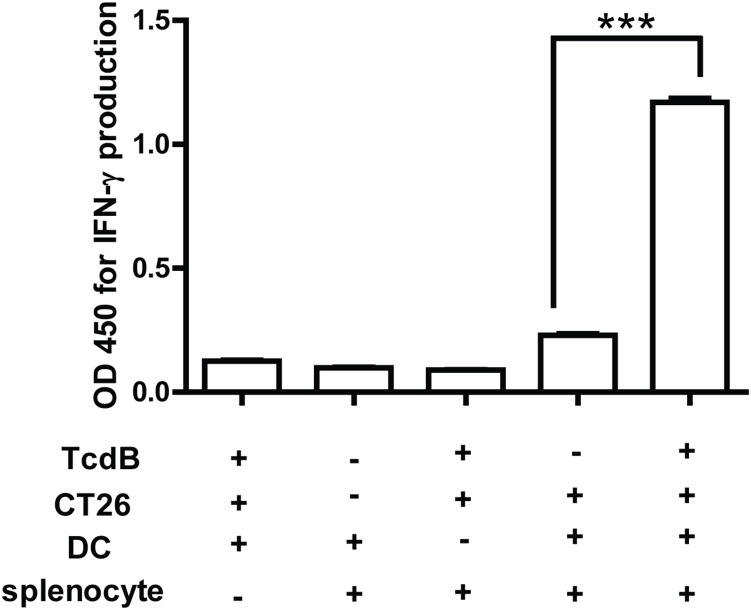
IFN-γ production induced by BMDCs loaded with TcdB-treated tumor cells.Autologous splenocytes were co-cultured with bone marrow DCs (BMDCs) preloaded with live or TcdB-intoxicated CT26 cells for two weeks, and the supernatant was collected to measure IFN-γ production by ELISA. Splenocytes incubated with mere DCs or mere TcdB-treated tumor cells were set as controls. The data represent the mean of three independent determinations ± SEM. ***represents P<0.001 (unpaired two-tailed t-test).